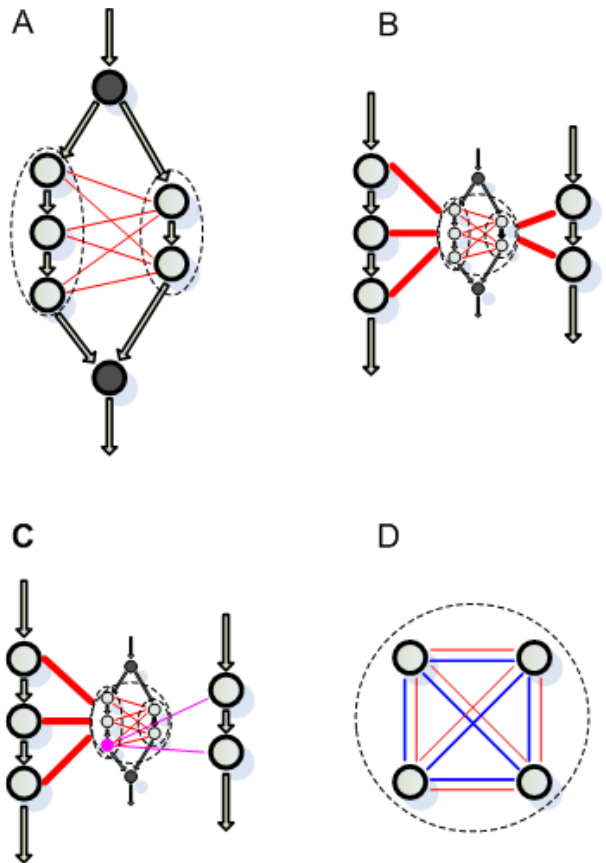
Figure 1. Possible mode of synthetic lethal interactions. Solid circles represent genes, arrows represent information flow, blue lines represent physical interactions and red/pink lines represent synthetic lethal interactions. Dashed circles group genes into pathways. ( A–C ), Compensatory pathways: ( A ) The information flow from one master gene (filled circle on the top) can go through either of the two pathways and get to another master gene (filled circle on the bottom). Thus mutation of any single genes in either pathway will not block the information flow, while a double mutation where both pathways are disabled will block the information flow and the cell will die, if this information flow is critical to its survival. However, synthetic lethal interactions are depleted from either pathway since a double deletion in either pathway will not cause lethal effect. ( B ) Genes involved in the same function generally have similar patterns of synthetic lethal interaction with genes from other pathways. Heavy red lines indicate that all genes grouped by the large dashed circle have synthetic lethal interaction with the other genes. ( C ) Multifunction effect. A gene (or a pathway) may have multiple functions. All single-function genes (empty circles) grouped by the dashed circle tend to have similar synthetic lethal interaction patterns. However, a multifunction gene, as indicated by the pink circle, may have a synthetic lethal interaction pattern (the additional synthetic lethal interactions shown with pink lines) that differs from the other genes grouped by the dashed circle. (D) Single pathway: A certain protein complex/pathway can sustain the mutation of one, but not two, member genes without loss of function.